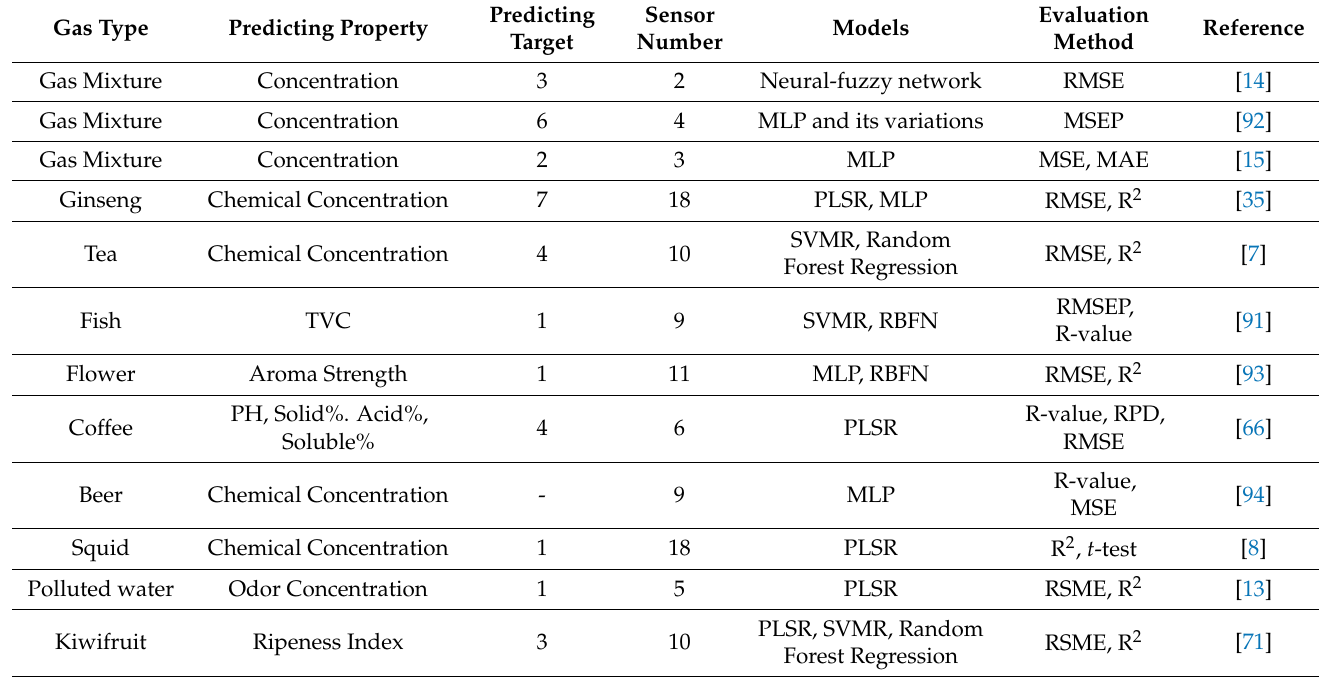
Table 3. Summary of commonly used model in E-Nose gas concentration